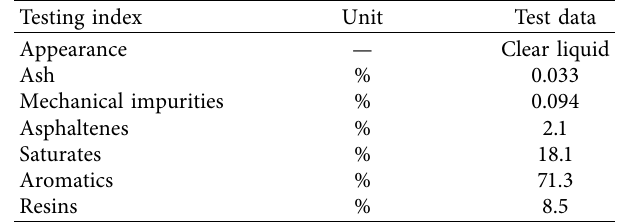
Table 1: WEOB basic properties.